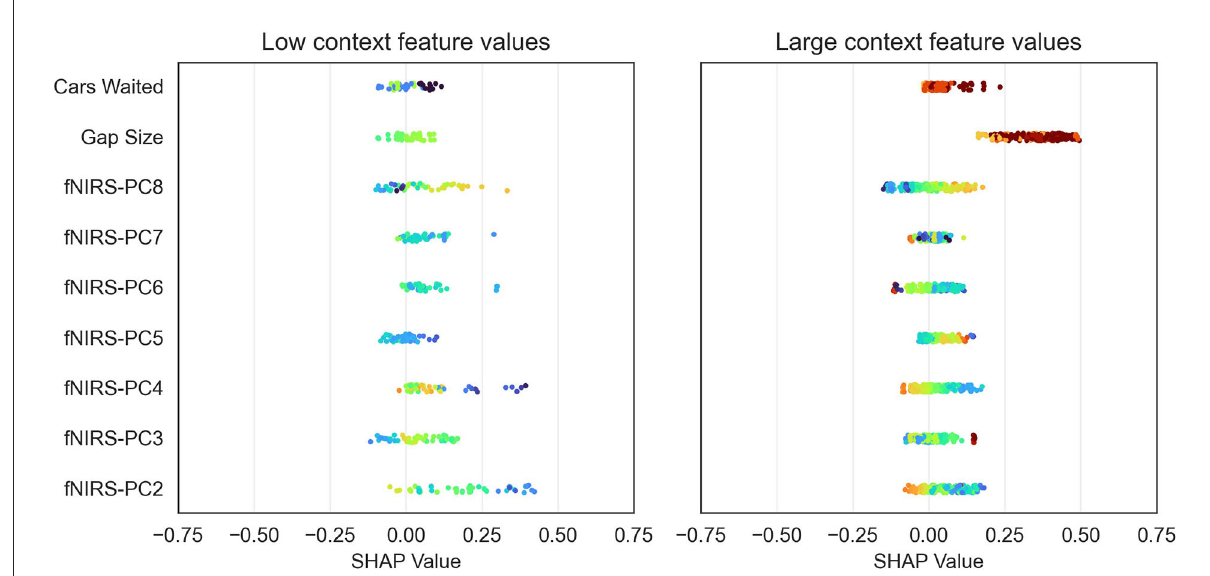
FIGURE10 Beeswarm plots comparison of low and high context feature values for one subject and false negatives of the context only model. Left: Only samples with low context feature values. The combined model learned to utilize the brain activation features for the correct classification. This is indicated by the higher fNIRS SHAP values. Right: For large context feature values, the impact of the context features is on average higher than the brain activation